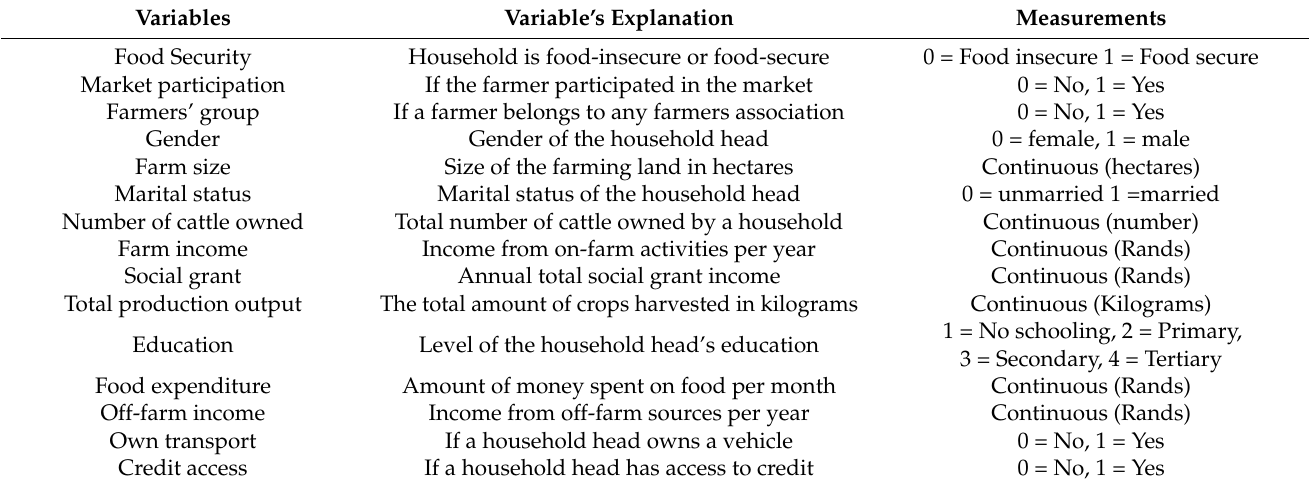
Table 2. Description, definition, and values of variables used in the probit